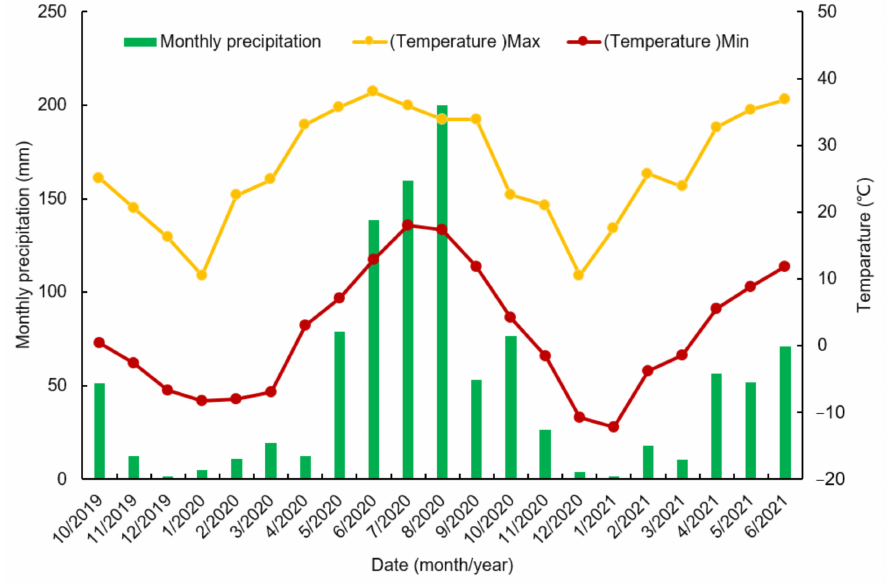
Figure 1. Precipitation and temperatures during field tests.